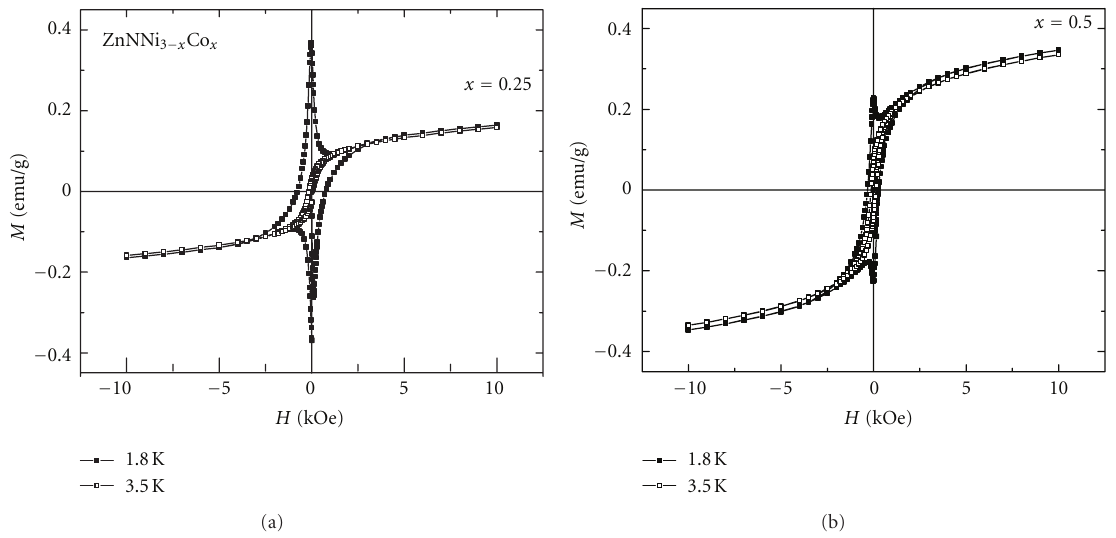
Figure 3: Magnetic field dependence of magnetization at 1.8 and 3.5K for ZnNNi 3 − x Co x with (a) x = 0 . 25 and (b) x = 0 . 5.